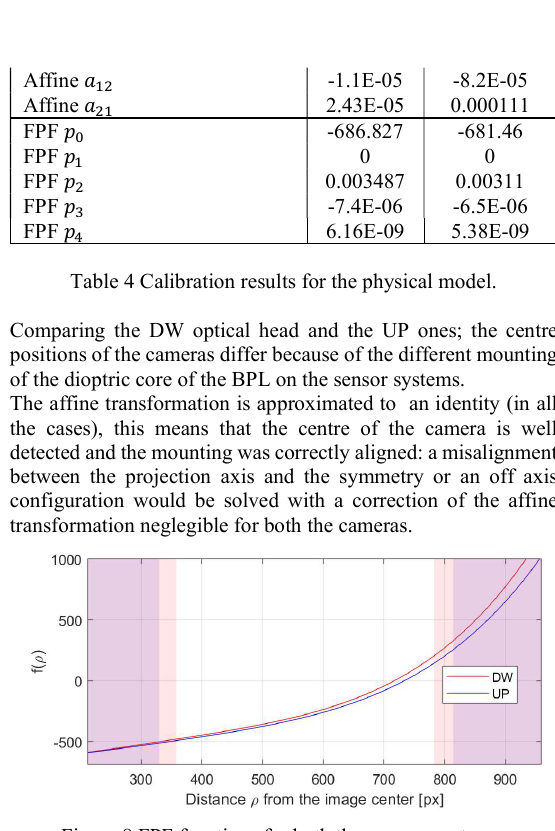
Figure 8 FPF functions for both the camera systems.